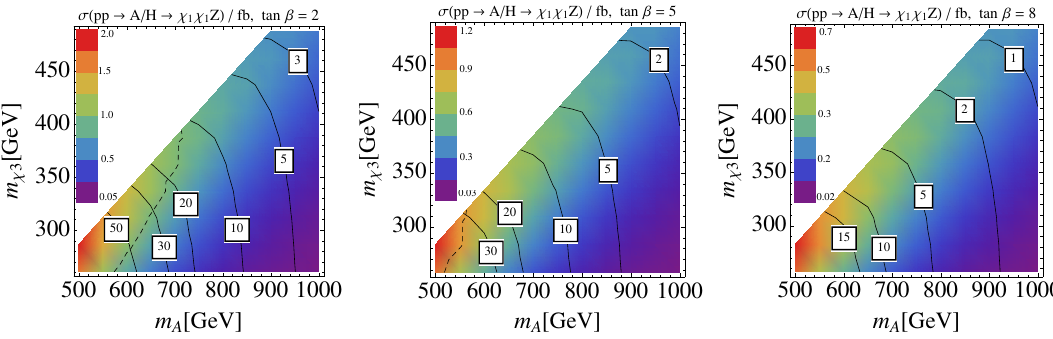
Figure 4 . 13 TeV production cross section for the process pp ! A; H ! (cid:31) 1 ( (cid:31) h ! (cid:31) 1 Z ), where h = 2 ; 3 and we sum over both A and H , as a function of m A and m (cid:31) and right panels, respectively). For these plots we (cid:12)x M 1 such that m (cid:31) and decouple all other particles by setting other dimensionful parameters to 2 TeV. The color coding represents the ratio of the cross section for this process to direct neutralino production cross section, (cid:27) ( pp ! A; H ! (cid:31) 1 ( (cid:31) h ! (cid:31) 1 Z )) =(cid:27) ( pp ! neutralinos ! Z + =E T )), where we sum over all possible neutralino combinations that can give rise to a mono-Z signal in the denominator (including topologies such as (cid:31) 2 (cid:31) 3 , which gives a mono-Z signal when one of the Z s decays invisibly). The dashed curve in the left panel indicates the contour along which these two production cross sections (direct and via heavy Higgs decays) are equal. All regions of parameter space presented in these panels are consistent with current LHC bounds from A=H ! (cid:28)(cid:28) [1, 2] as well as pp ! (cid:31) 2 (cid:31) (cid:6)